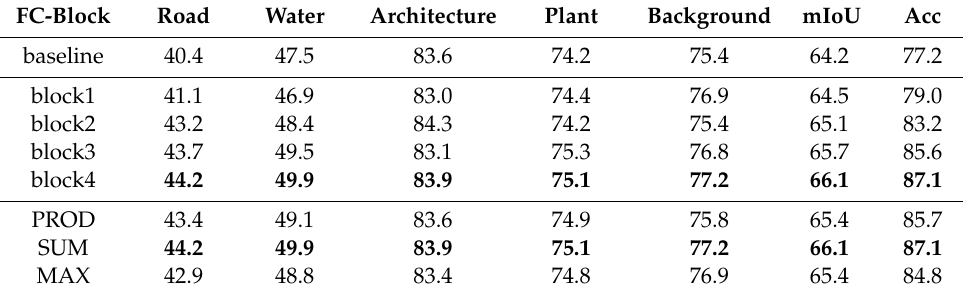
Table 2. Ablation studies on FC fusion path on HRRS data in terms of mean Intersection of Union (IoU) (mIou) and Acc. The best model performance is shown in bold.